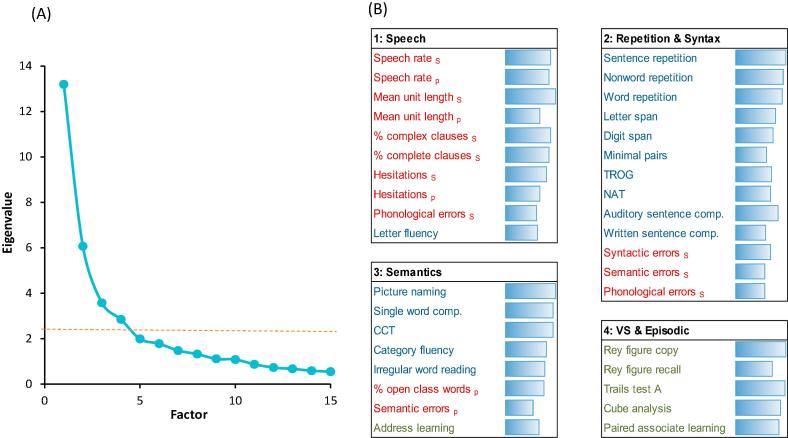
Results of principal components analysis. (A) Scree plot, indicating an elbow and marked reduction in eigenvalues after four factors. (B) Individual performance measures loading on each of the four factors. Measures with loadings >0.5 are listed. Connected speech markers are shown in red, neuropsychological language/semantic tests in blue and other neuropsychological tests in green. Bars indicate the strength of the loading of each measure. S and P sub-scripts denote speech markers derived from either semi-structured interviews or from picture description. TROG = Test of Reception of Grammar (Bishop, 1982), NAT = Northwestern Anagram Test (Weintraub et al., 2009), CCT = Camel & Cactus Test (Bozeat, Lambon Ralph, Patterson, Garrard, & Hodges, 2000).